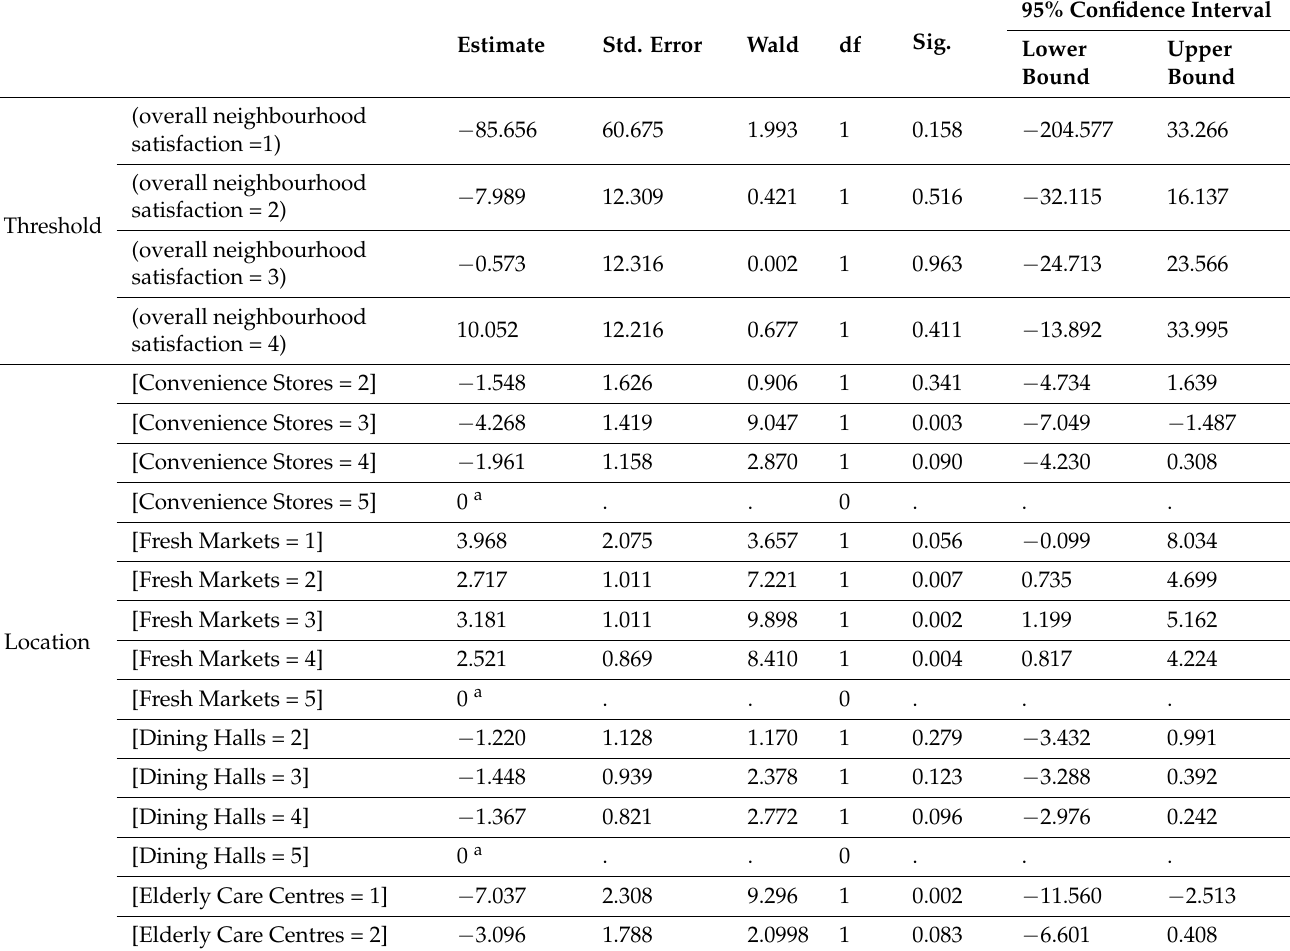
Table A4. Parameter